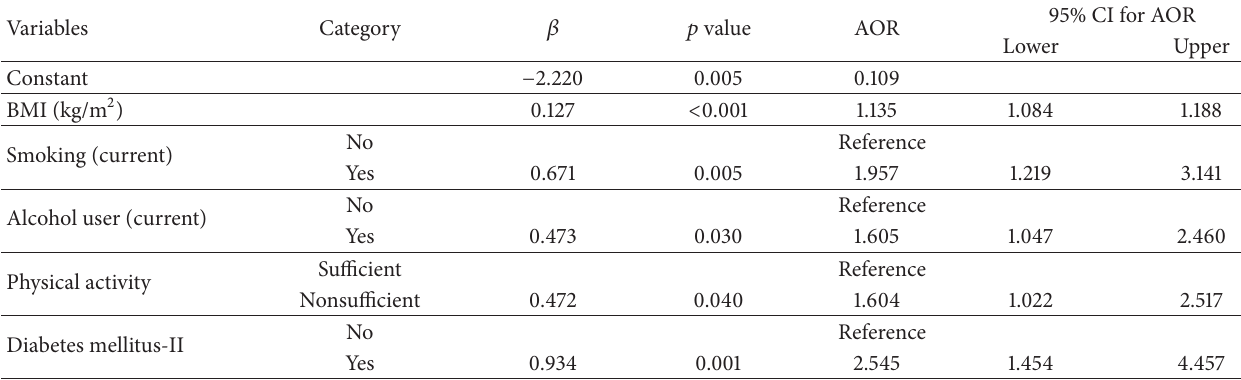
Table 4: Multivariable analysis for